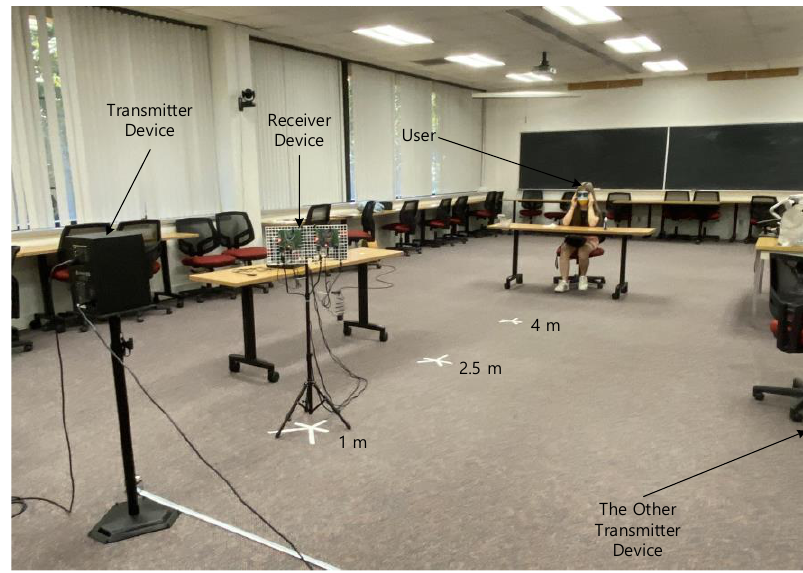
Figure 18. Human perception experiment configuration.